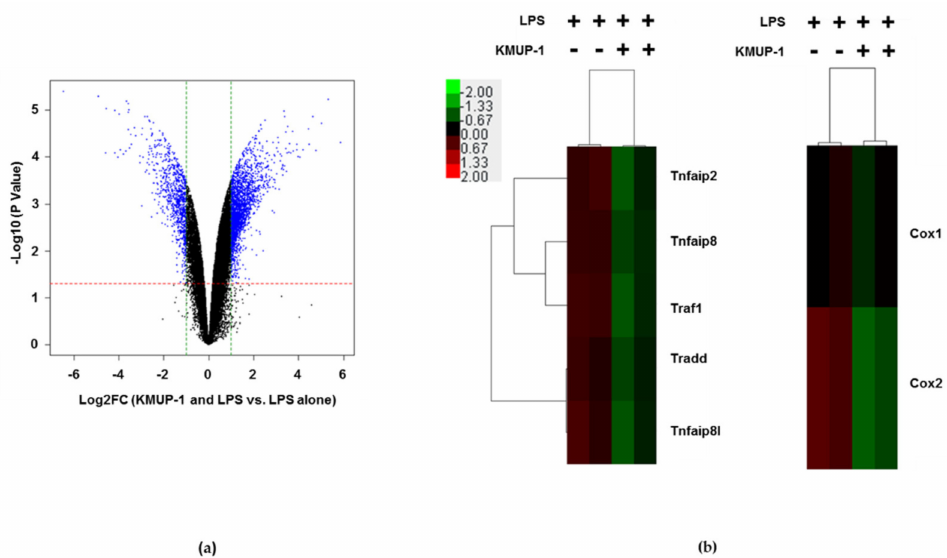
Figure 4. The microarray analysis to determine different expressed transcripts. Volcano plots indicate the differentially expressed transcripts in RAW 264.7 cells pretreatment with 10 µ M KMUP-1 for 1 h and/or 1 µ g/mL LPS for additional 24 h. The negative log10 transformed p -values ( y - axis) were plotted against the average log2-fold change ( x -axis) in gene expression. Transcripts with a p -value ≤ 0.05 and two-fold up- or downregulated were classified as statistically significant. ( a ) Volcano plot shows LPS-stimulated RAW 264.7 cells compared to LPS + KMUP-1 treatment. Significantly differentially expressed transcripts are showed in blue dotted line, which indicates the -log10 of p ≤ 0.05. ( b ) Clustering analysis was performed to visualize the correlations among the replicates and varying sample